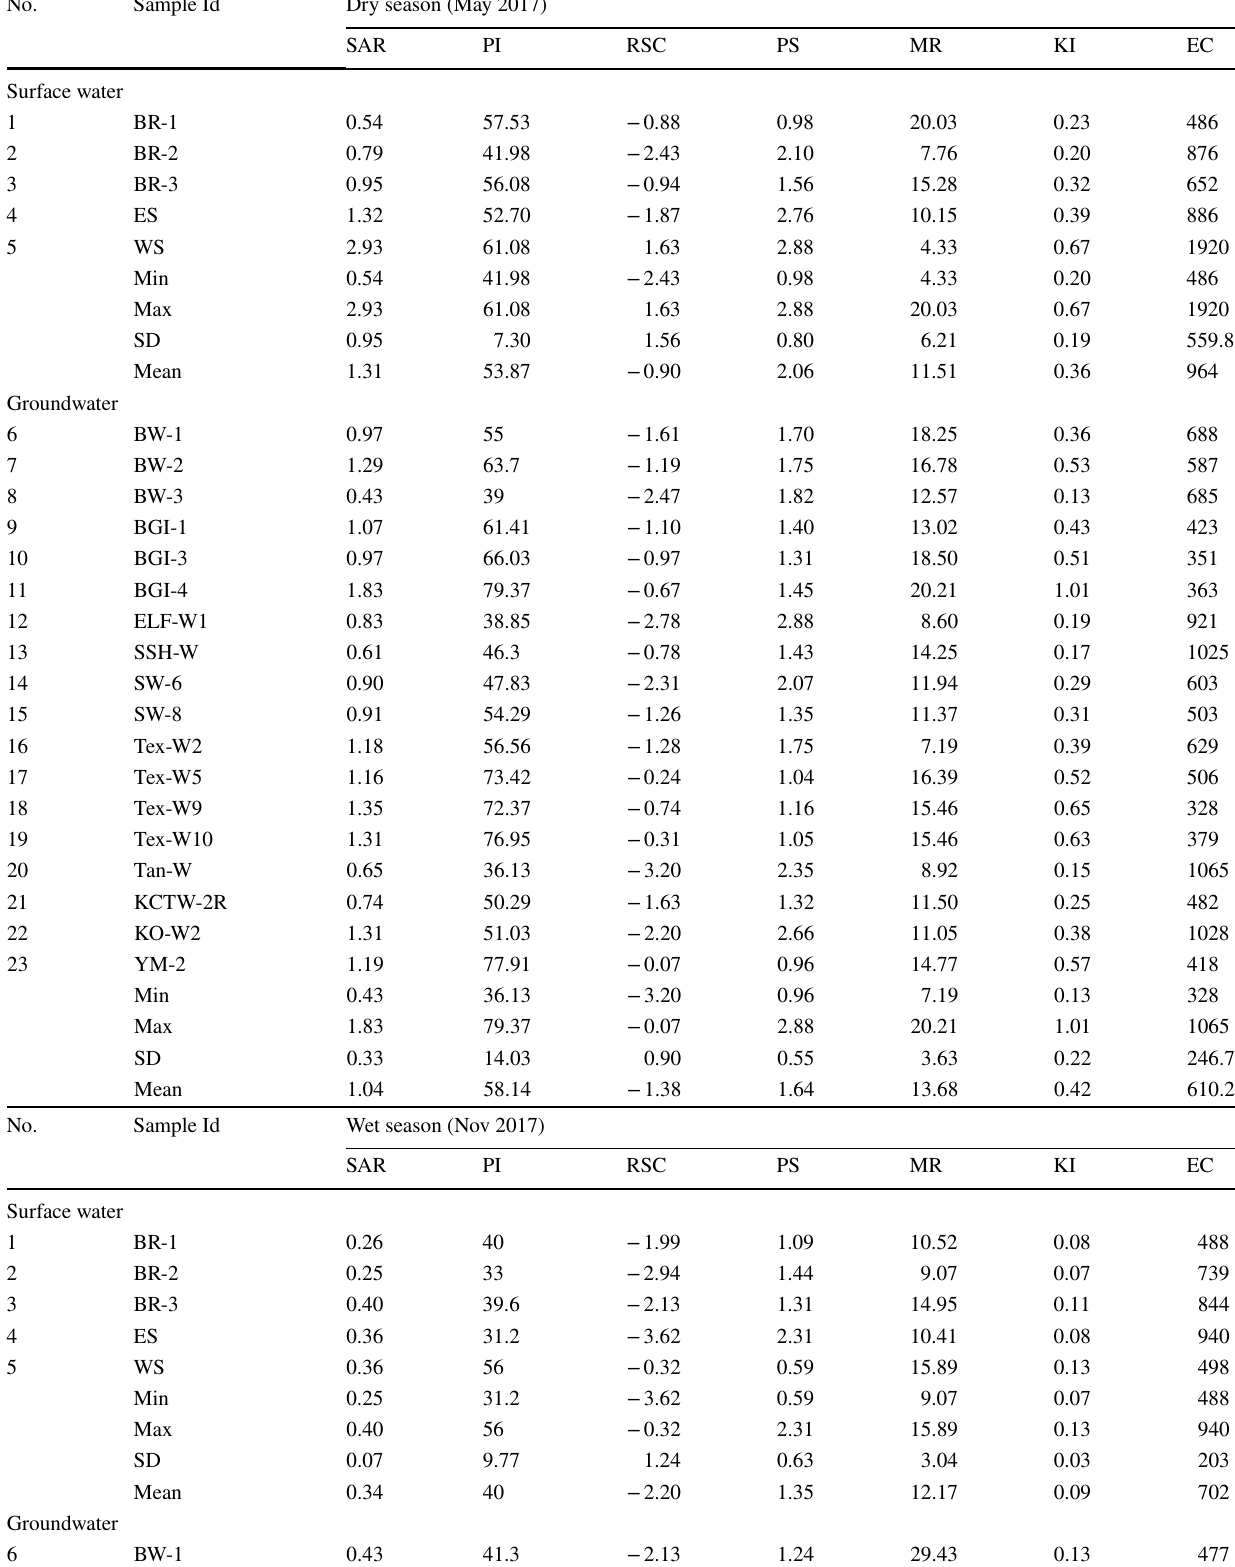
Table 7 Results of water quality indices for irrigation